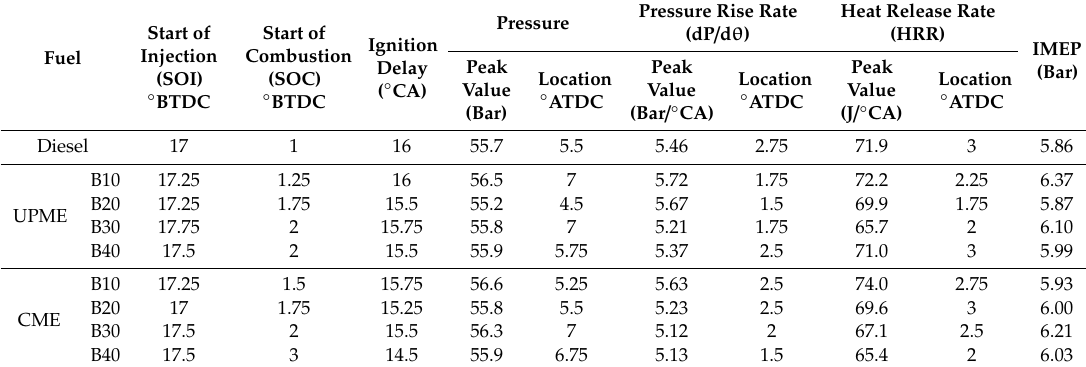
Table 5. Combustion characteristics of the